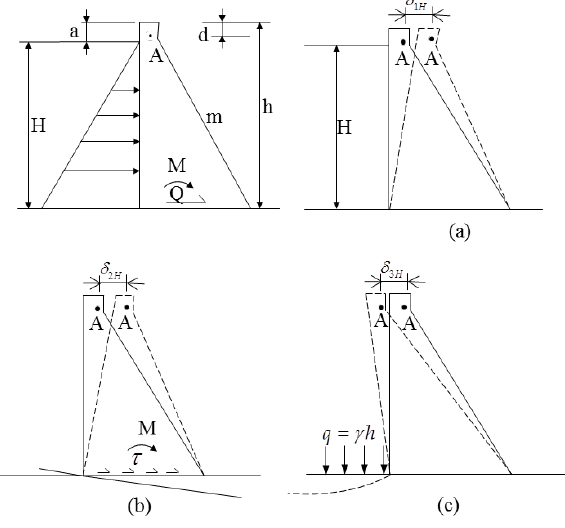
Figure 1. The three components of δ H : ( a ) δ 1 H , ( b ) δ 2 H and ( c ) δ 3 H